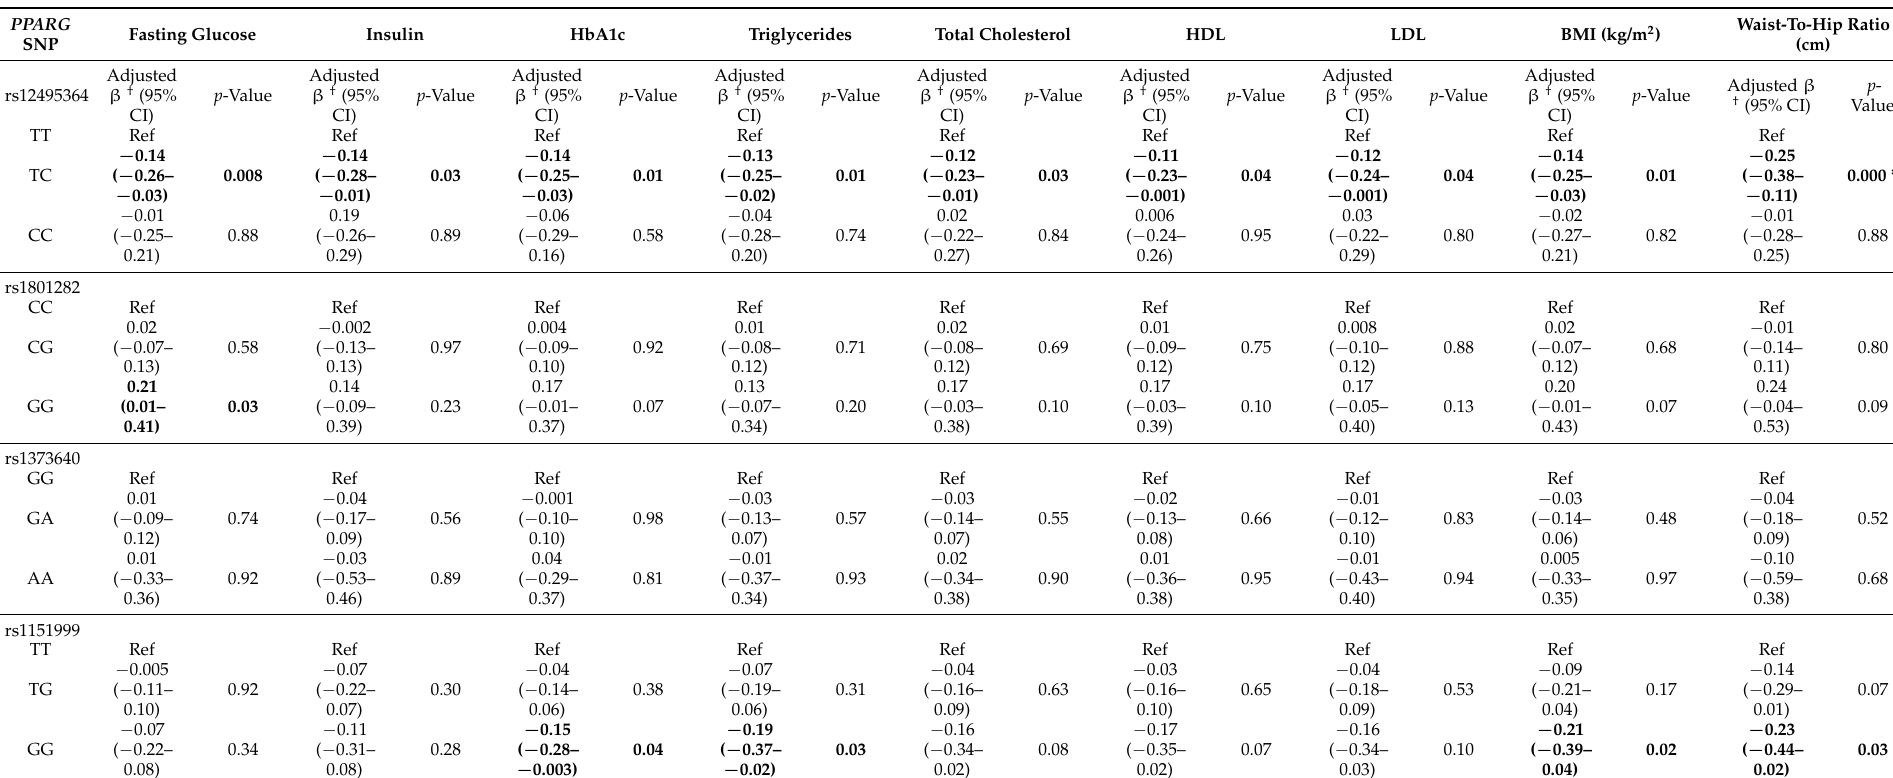
Table 3. Multiple linear regression analysis of all subjects for effects of single nucleotide polymorphisms on glycemic, lipid, and obesity